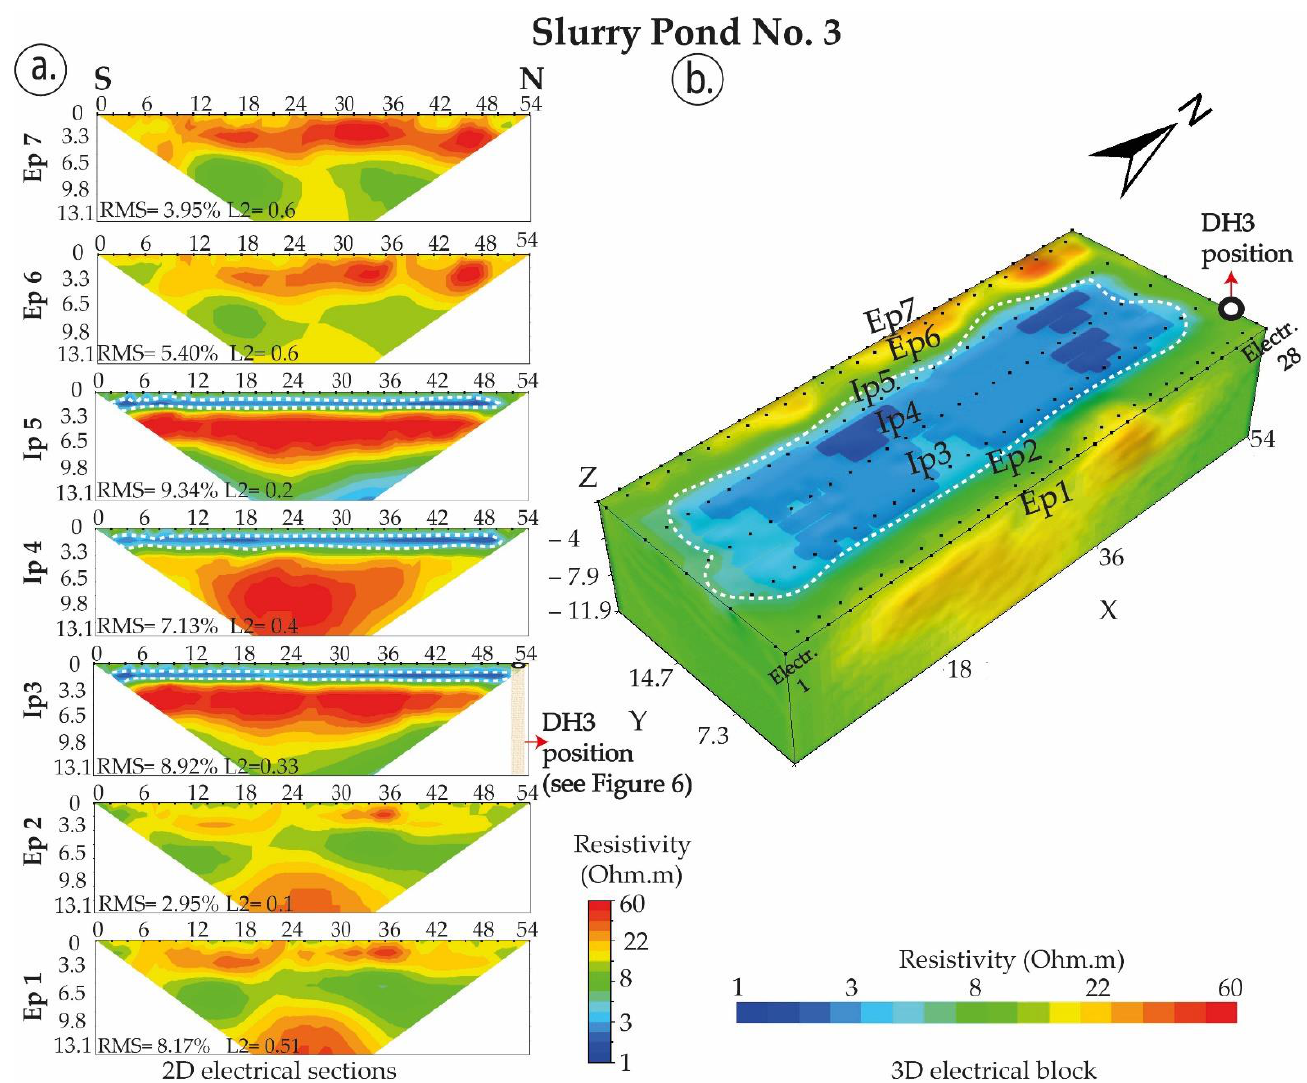
Figure 9. Slurry pond No. 3. ( a ) ERT 2D electrical sections and ( b ) ERT 3D electrical block. RMS and L2 stand for root-mean squared error and L2 norm, respectively. Electrode spacing is 2 m. At SP3, external ERT sections display resistivity values ranging from 9 to 40 Ohm.m.